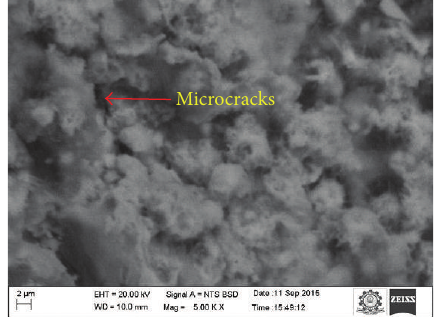
Figure 8: SEM image for SFCS30 specimen.